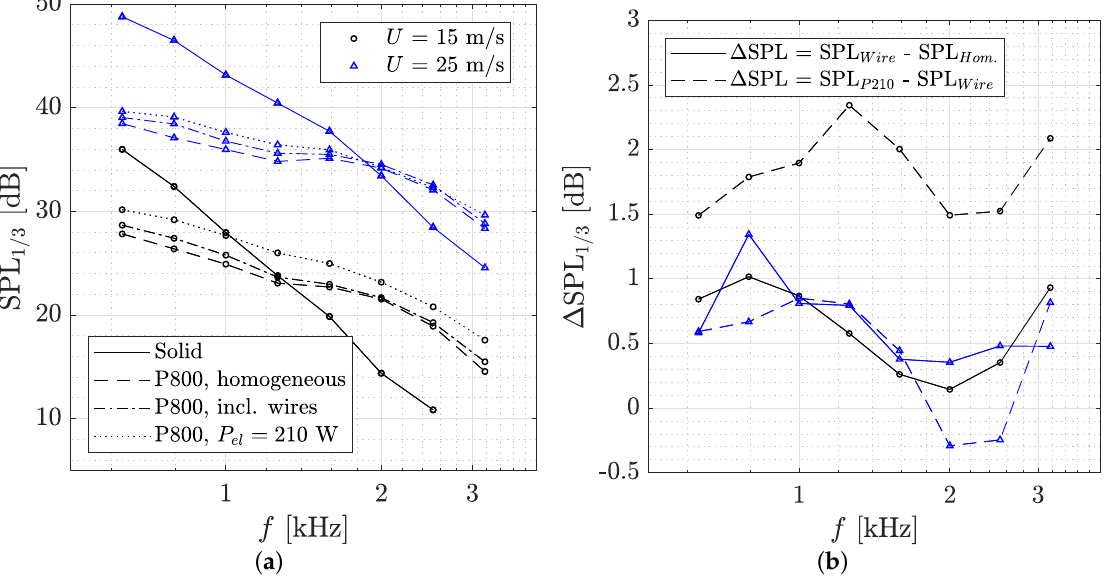
Figure 7. Comparison of far-field noise spectra of different heated and unheated trailing edge cases for U = 15ms − 1 and U = 25ms − 1 . SPLs as observed at a distance of 1m from the airfoil are depicted ( a ) as well as a comparison between selected measurement cases ( b